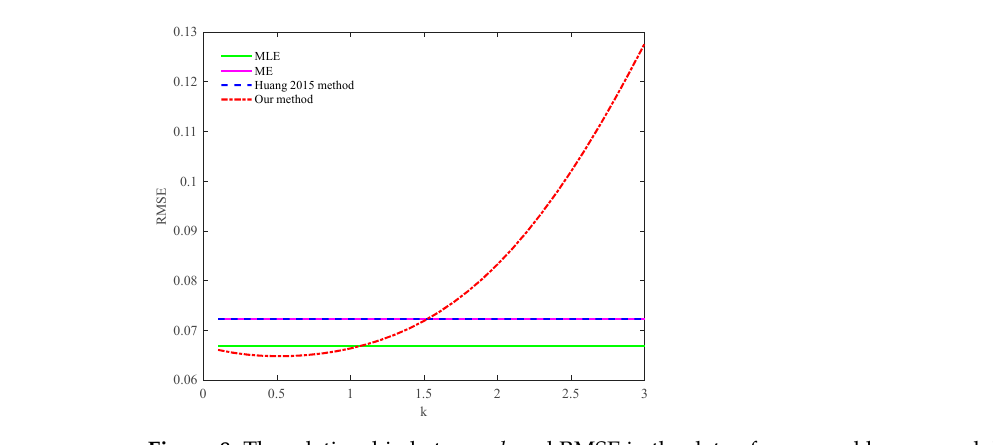
Figure 8. The relationship between k and RMSE in the data of measured log–normal distribution. Table 7. The calculation time in simulated log–normal distribution ( k = 0.5). Estimation